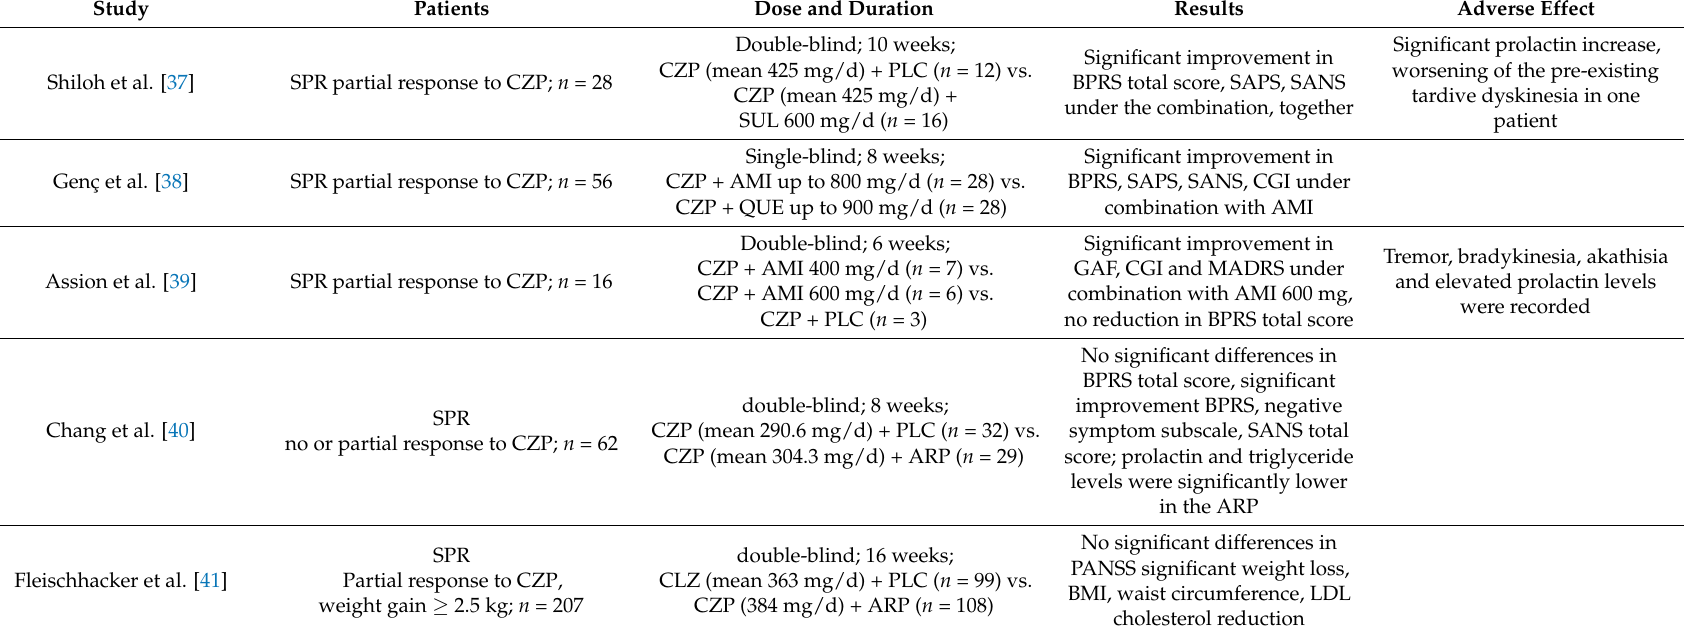
Table 2. Summary of randomized controlled studies of clozapine combined with sulpiride, amisulpride, quetiapine, and